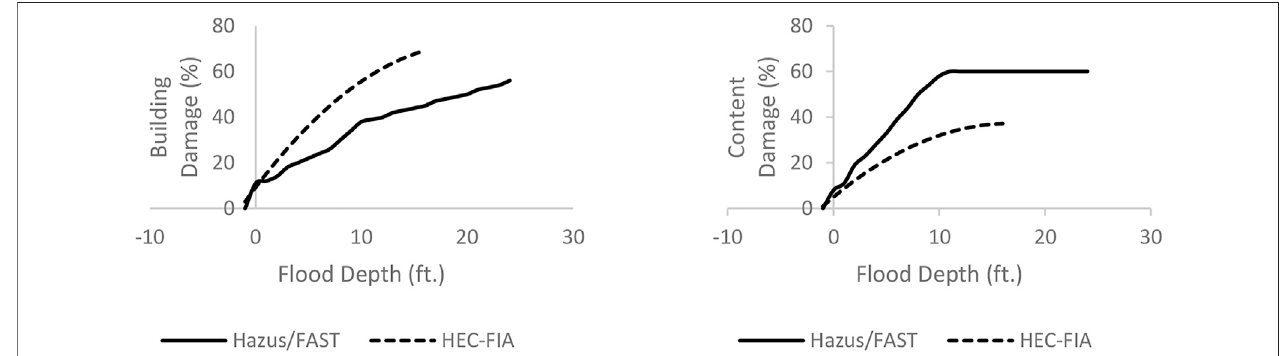
FIGURE 3 | Comparison of default depth-damage curves for building (left panel) and contents (right panel) , used in Hazus/FAST and HEC-FIA, for a one-story building with no basement.